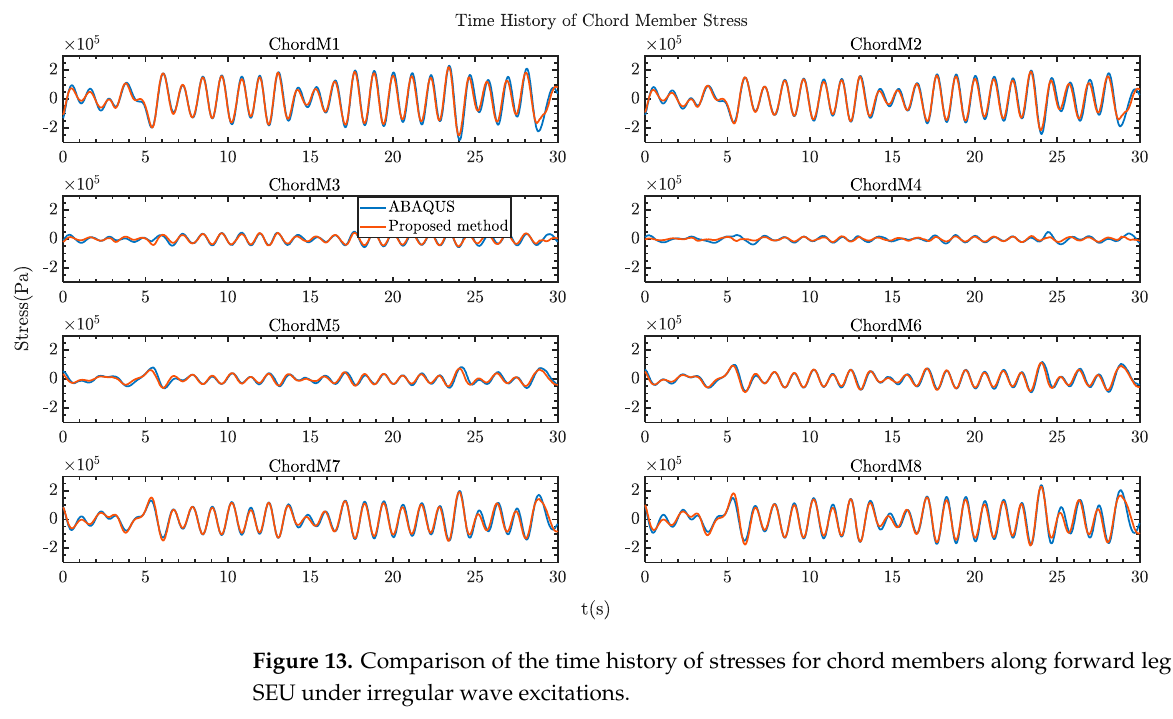
Figure 12. Comparison of the time history of nodal displacement in surge under irregular wave excitations.